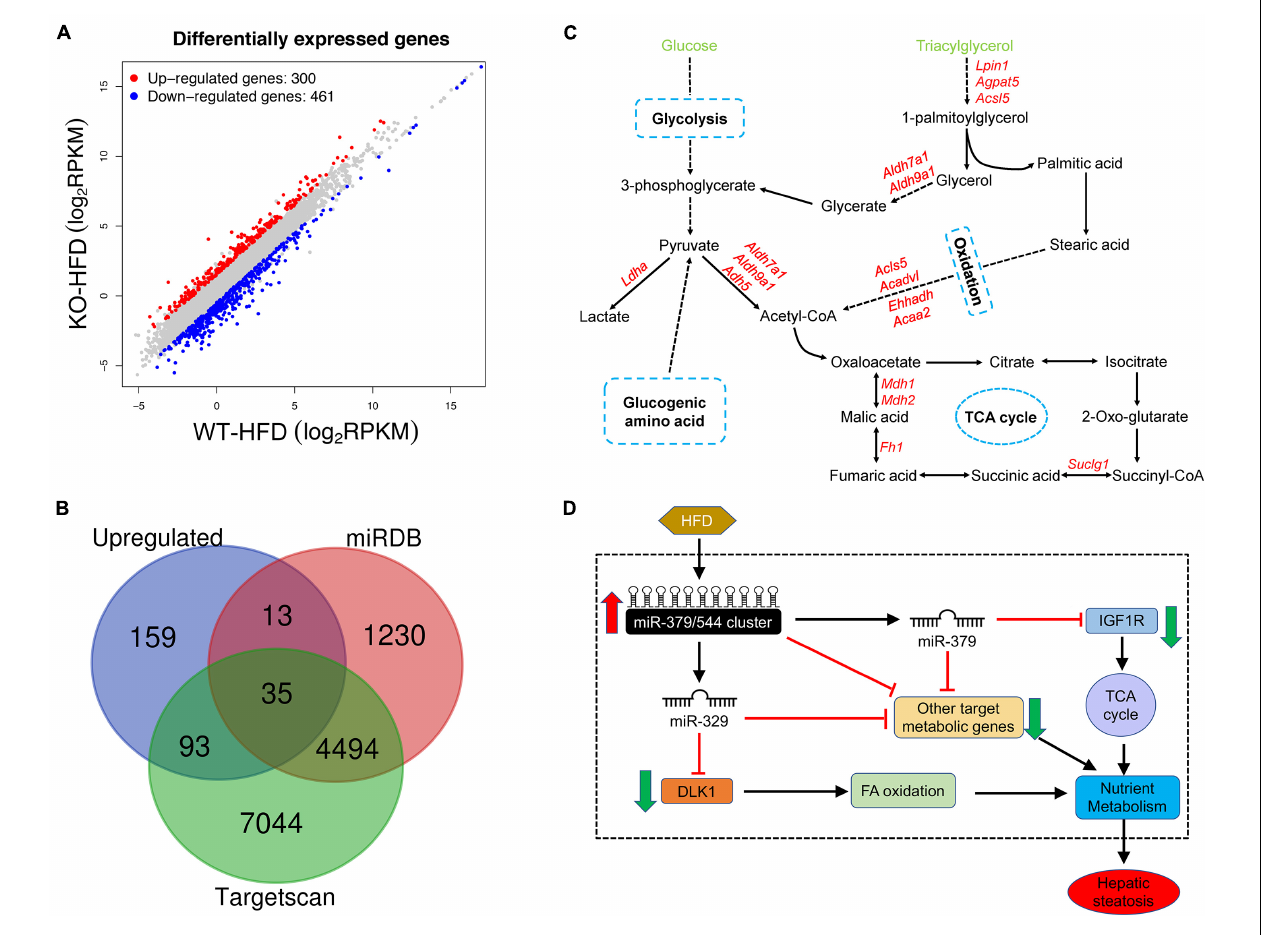
FIGURE 7 | miR-379/miR-544 cluster KO-HFD mice display dysregulation of hepatic gene expression. (A) Volcano plot showing differential expression of 761 significantly altered genes that determined by RNA-seq ( n = 3). (B) Venn diagram showing a comparison between significantly upregulated genes and genes predicted to be miR-379/miR-544 cluster targets by Targetscan and microCosm. (C) Schematic representation of the predicted metabolic genes targeted by miR-379/miR-544 cluster on glucose and triacylglycerol metabolism processes. (D) Schematic diagram of the working model of miR-379/miR-544 cluster in liver metabolic regulation. Igf1r , a transmembrane tyrosine kinase receptor, is a target of miR-379 that regulates the TCA cycle. Dlk1 is a target gene of miR-329 and involves in fatty acid oxidative metabolism. The miR-379/miR-544 cluster is proposed to be an integral component of a regulatory circuit that functions under conditions of metabolic stress to control the overall energy